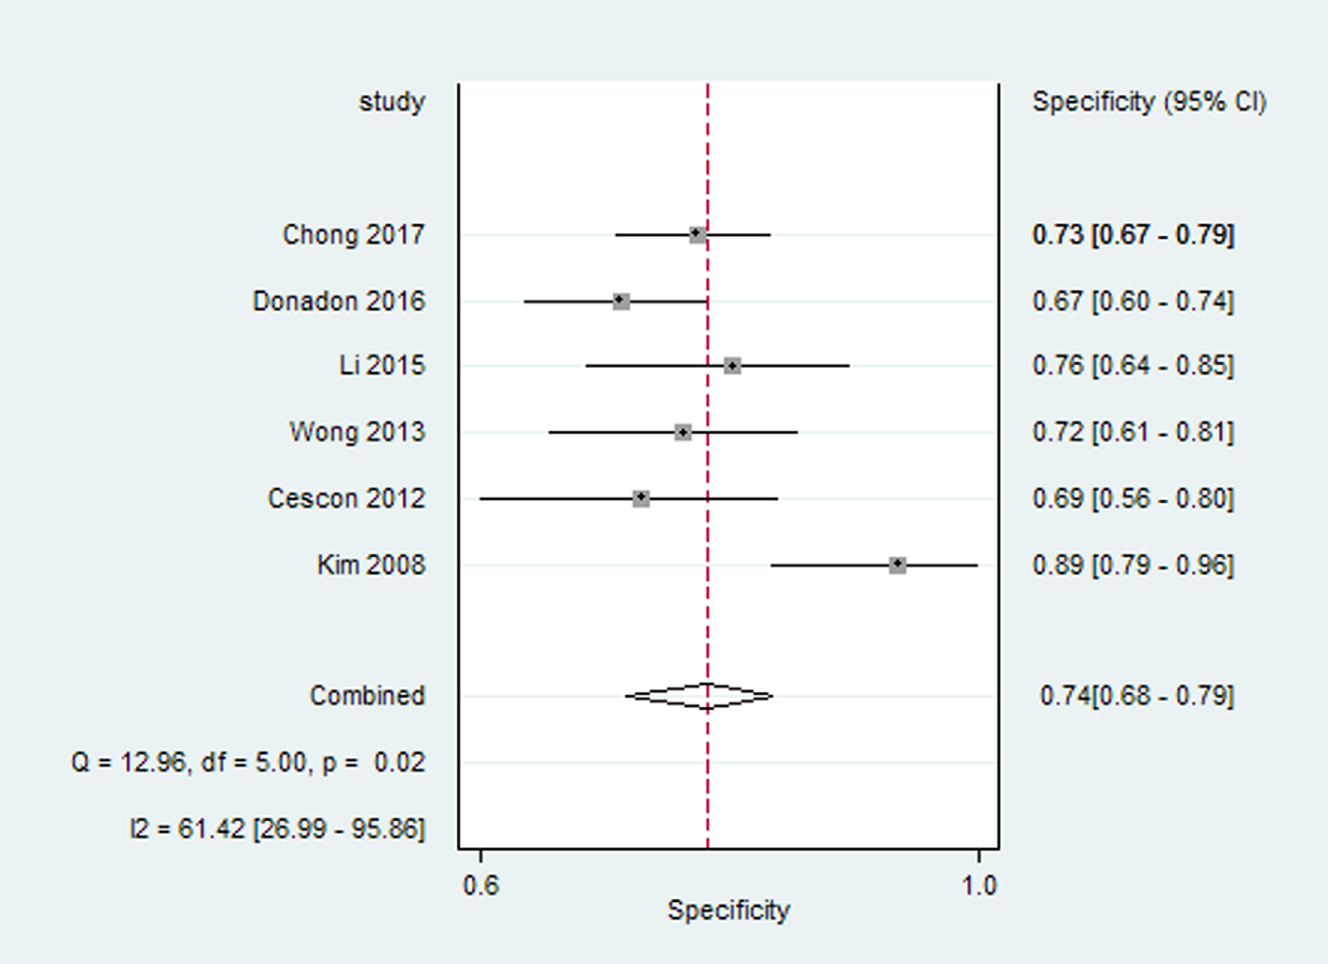
Fig 4. Forest plot meta-analyses of studies evaluating the specificity of live stiffness measured by TE to predict the overall postoperative complications.